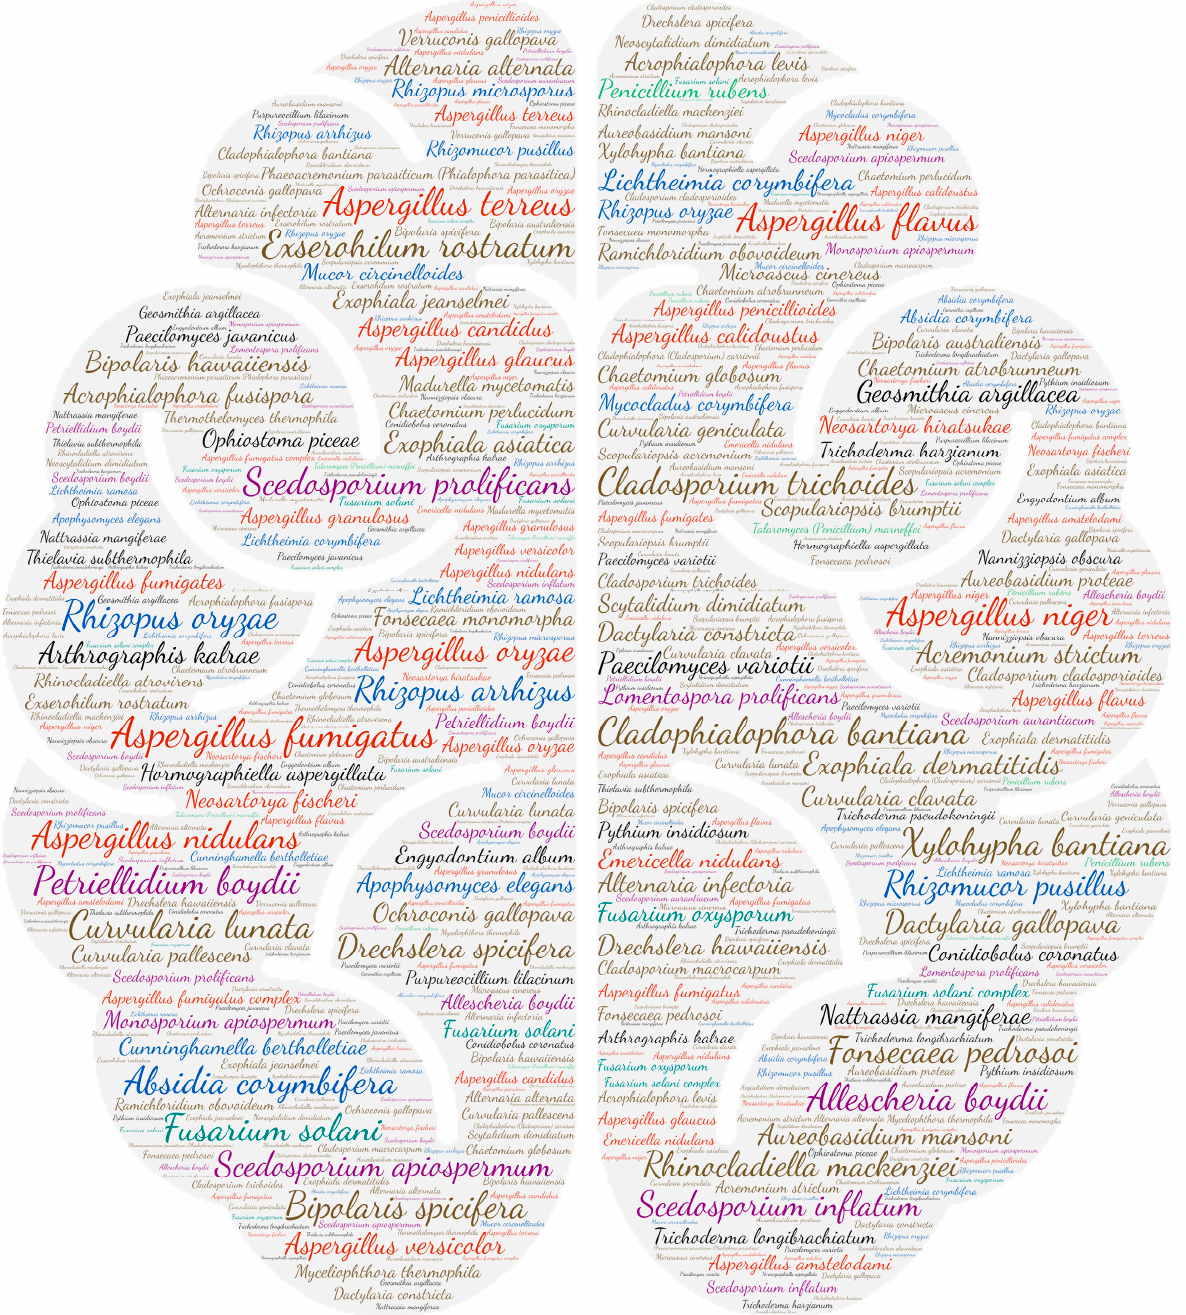
Figure 3. Wordcloud represents the species name isolated in the central nervous system. The size of the name of each species is proportional to the number of times it occurs in the repertoire.